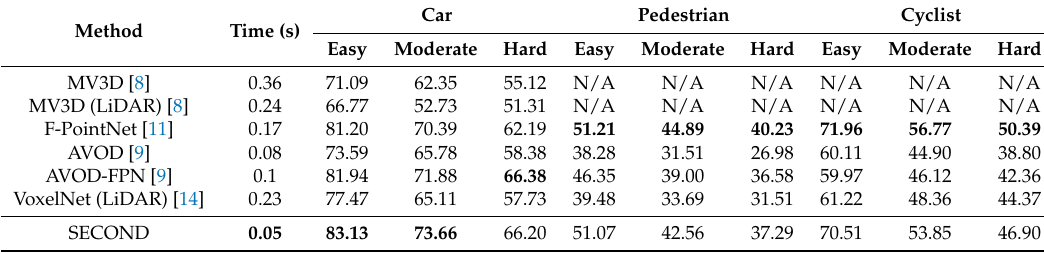
Table 2. 3D detection performance: Average precision (AP) (in %) for 3D boxes in the KITTI test set. In AVOD and AVOD-FPN [9], a custom 85/15 training/validation split and ground plane estimation are adopted to improve the results. For F-PointNet [11], a GTX 1080 GPU, which has 67% of the peak performance of a GTX 1080 Ti (used for our method) or a Titan Xp (used for AVOD), was used for inference. The bold number indicates the best result in a